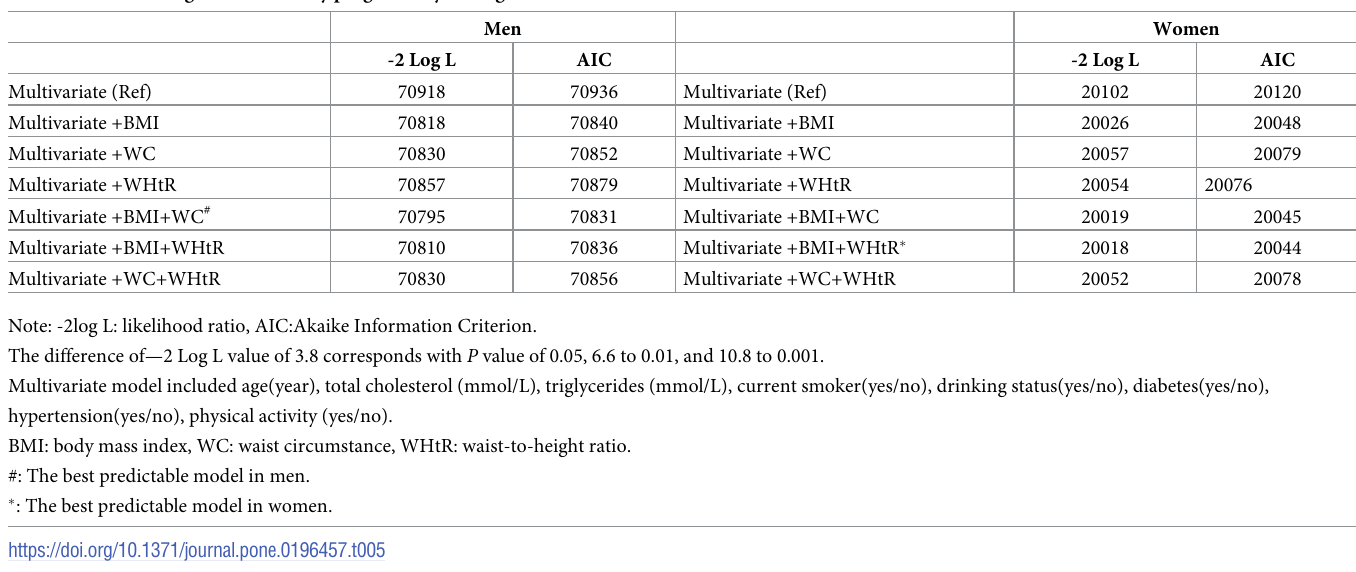
Table 5. Increases in goodness of fit by progressively adding to multivariate